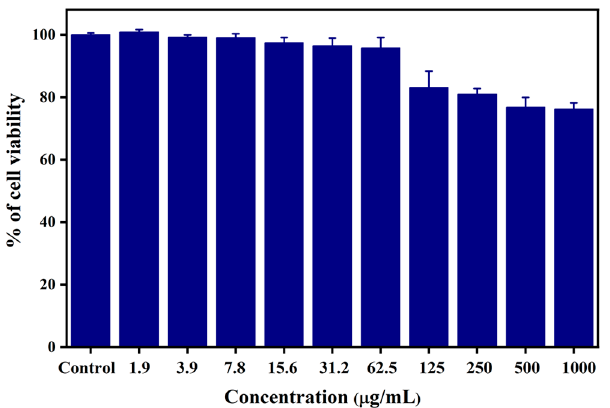
Figure 6. In vitro cytotoxicity of different concentration of Qn-AgNPs on HEK-293 cells.